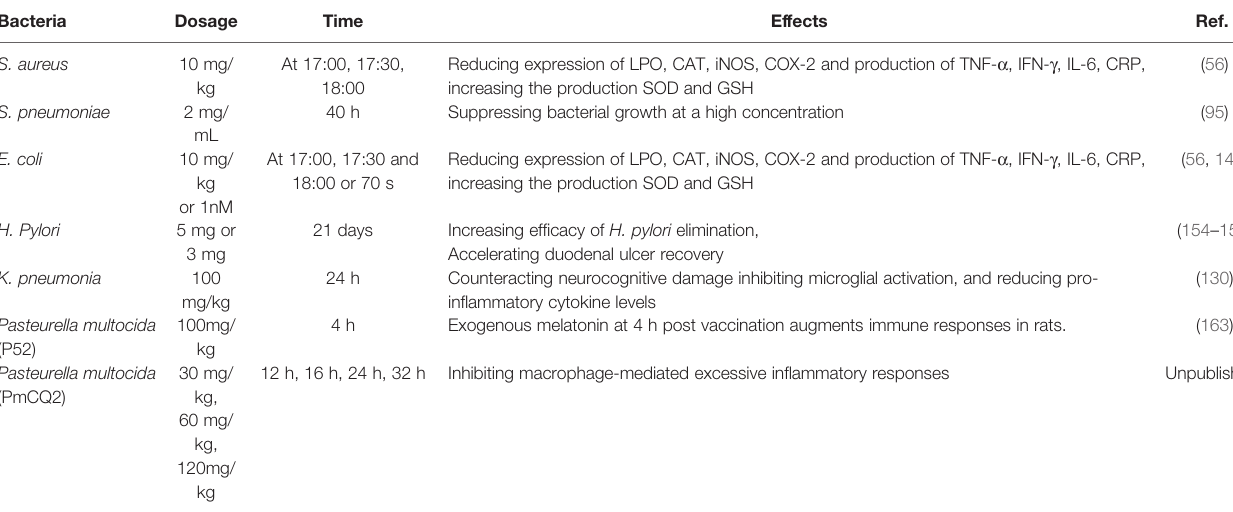
TABLE 2 | The antibacterial action of melatonin in vivo infected with different bacteria. Bacteria Dosage Time Effects